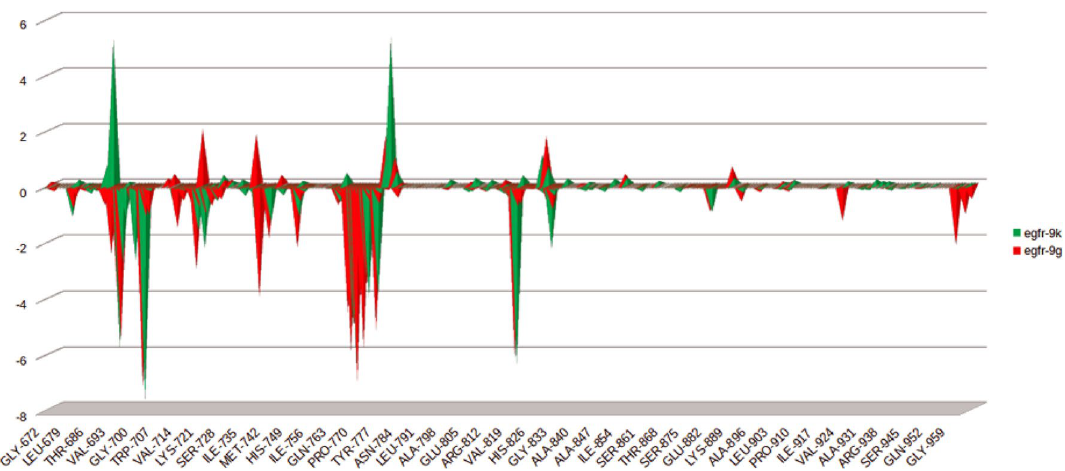
Figure 9. The per residue contribution for the binding free energy of 9g and 9k with